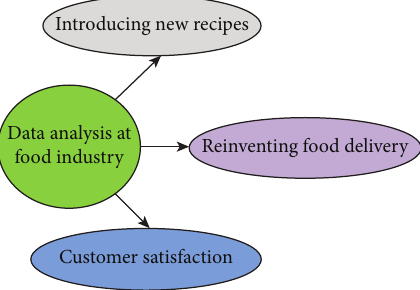
Figure 5: Data analysis at food